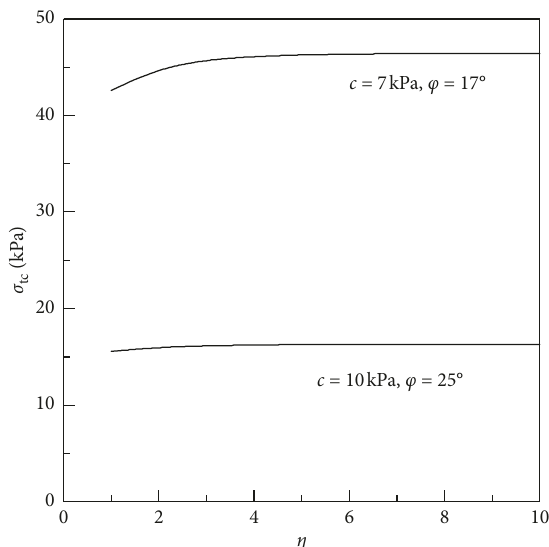
Figure 2: Influence of the coefficient η on the critical results ( D